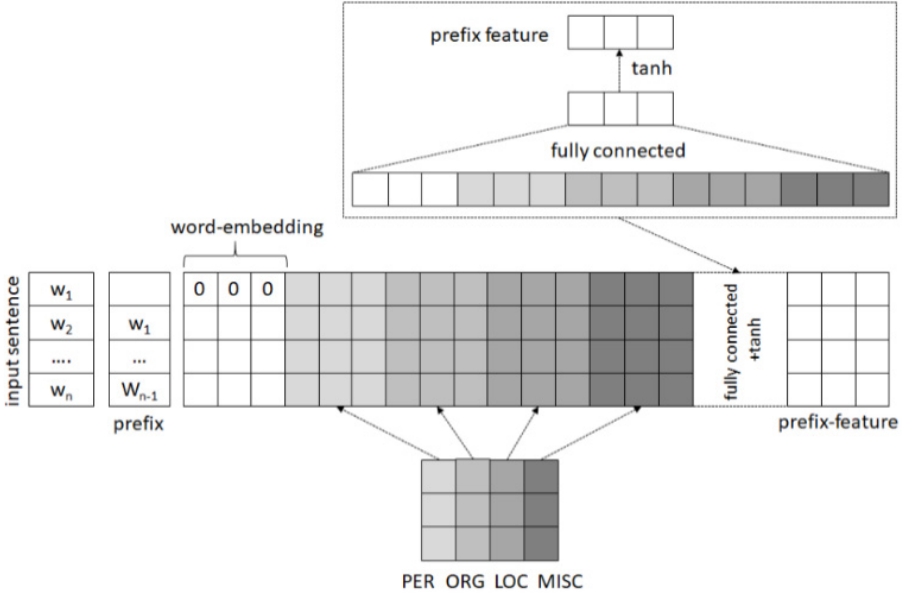
Fig. 3. Pre¯x feature